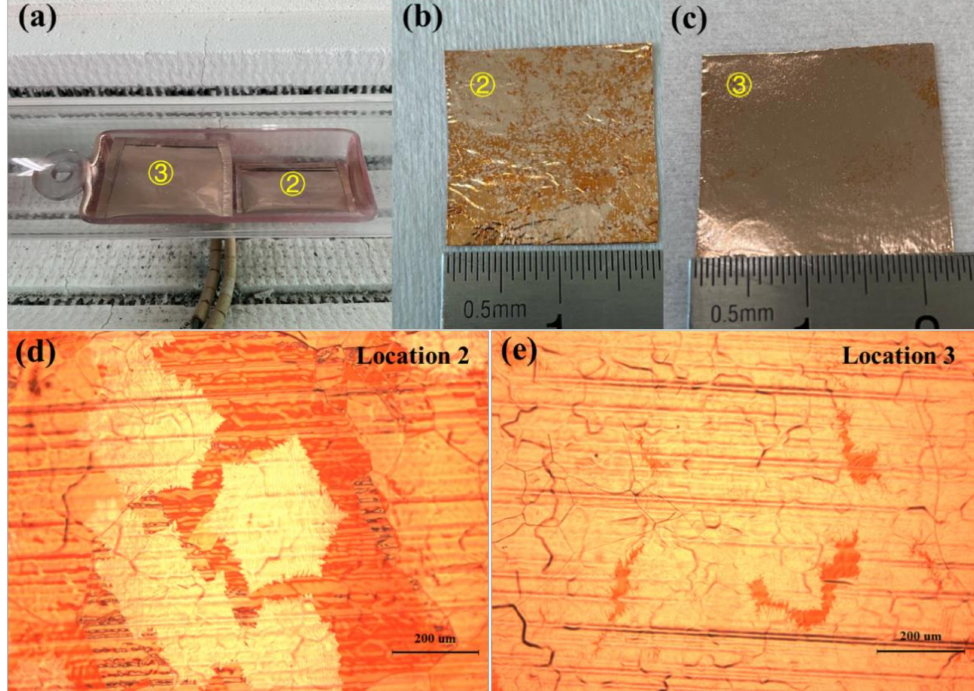
Figure 2. ( a ) Optical picture of the two copper pockets placed in the quartz boat in the first experiment. ( b , c ) Optical picture of the inner surfaces of the copper pockets at location 2 and location 3 after oxidation treatment. ( d , e ) Optical micrograph of the inner surfaces of the copper pockets at location 2 and location 3 under 100-times